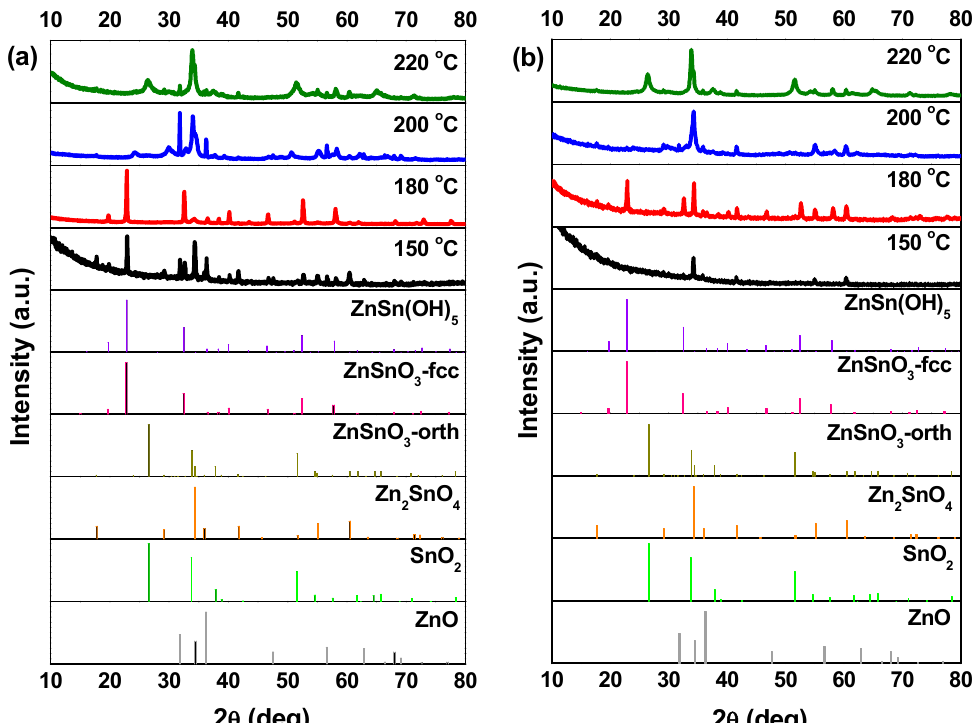
Figure 4. XRD patterns when using ( a ) ZnCl 2 precursor (with 2:1 Zn:Sn ratio) and ( b ) ZnAc precursor (with 1:1 Zn:Sn ratio), at different temperatures: 150 °C, 180 °C, 200 °C, and 220 °C. Identification following ICDD card 00-028-1486 (ZnSnO 3 -orth—deleted), 00-011-0274 (ZnSnO 3 -fcc), 00-024-1470 (Zn 2 SnO 4 ), 01-077-0452 (SnO 2 ), and 00-06-1451 (ZnO).